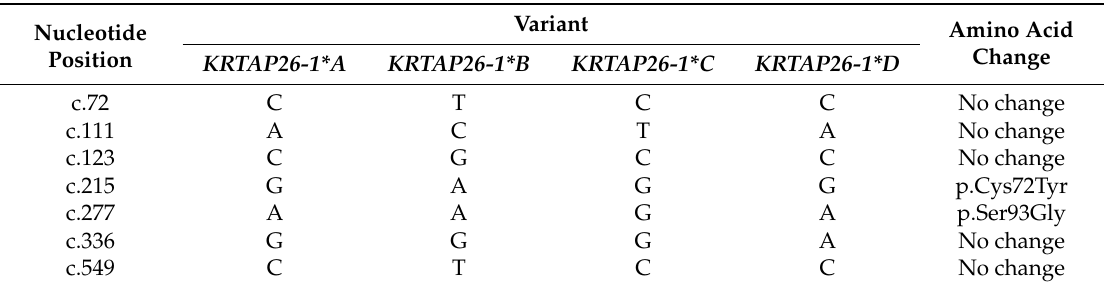
Figure 2. Polymerase chain reaction-single stranded conformational polymorphism (PCR-SSCP) identification of variation in the coding region of ovine KAP26-1 gene. Four banding patterns, representing four variants ( A to D ) are shown, for either homozygous or heterozygous sheep. Table 2. Sequence variations identified in the four variants of ovine KRTAP26-1 .